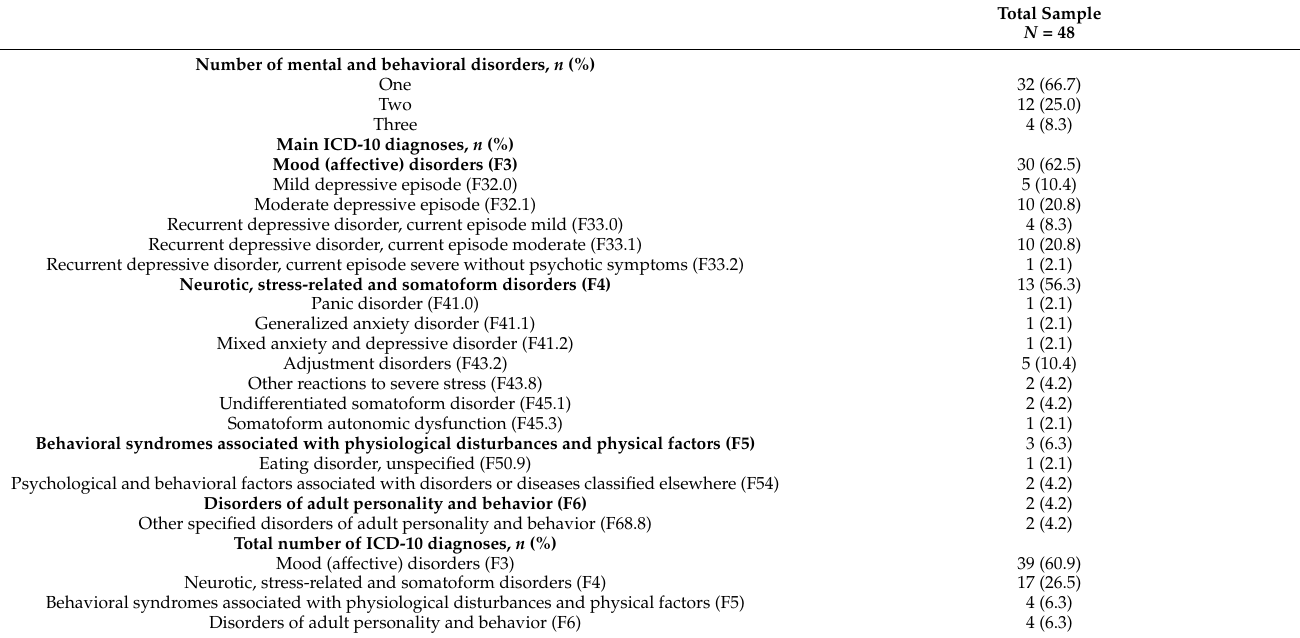
Table 2. Number of ICD-10 coded mental and behavioral disorders of the total sample.